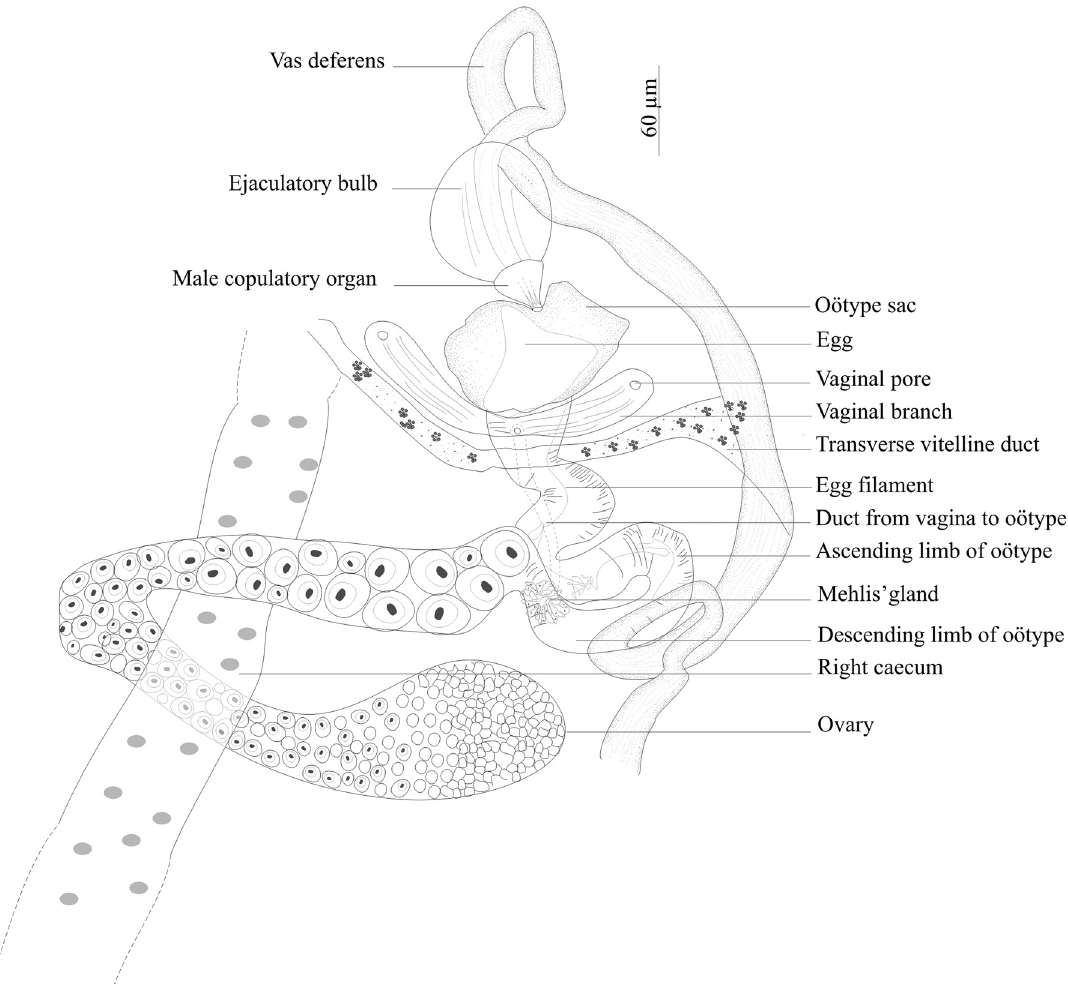
Figure 5. Triloculotrema euzeti n. sp. reproductive organs, paratype, ventral